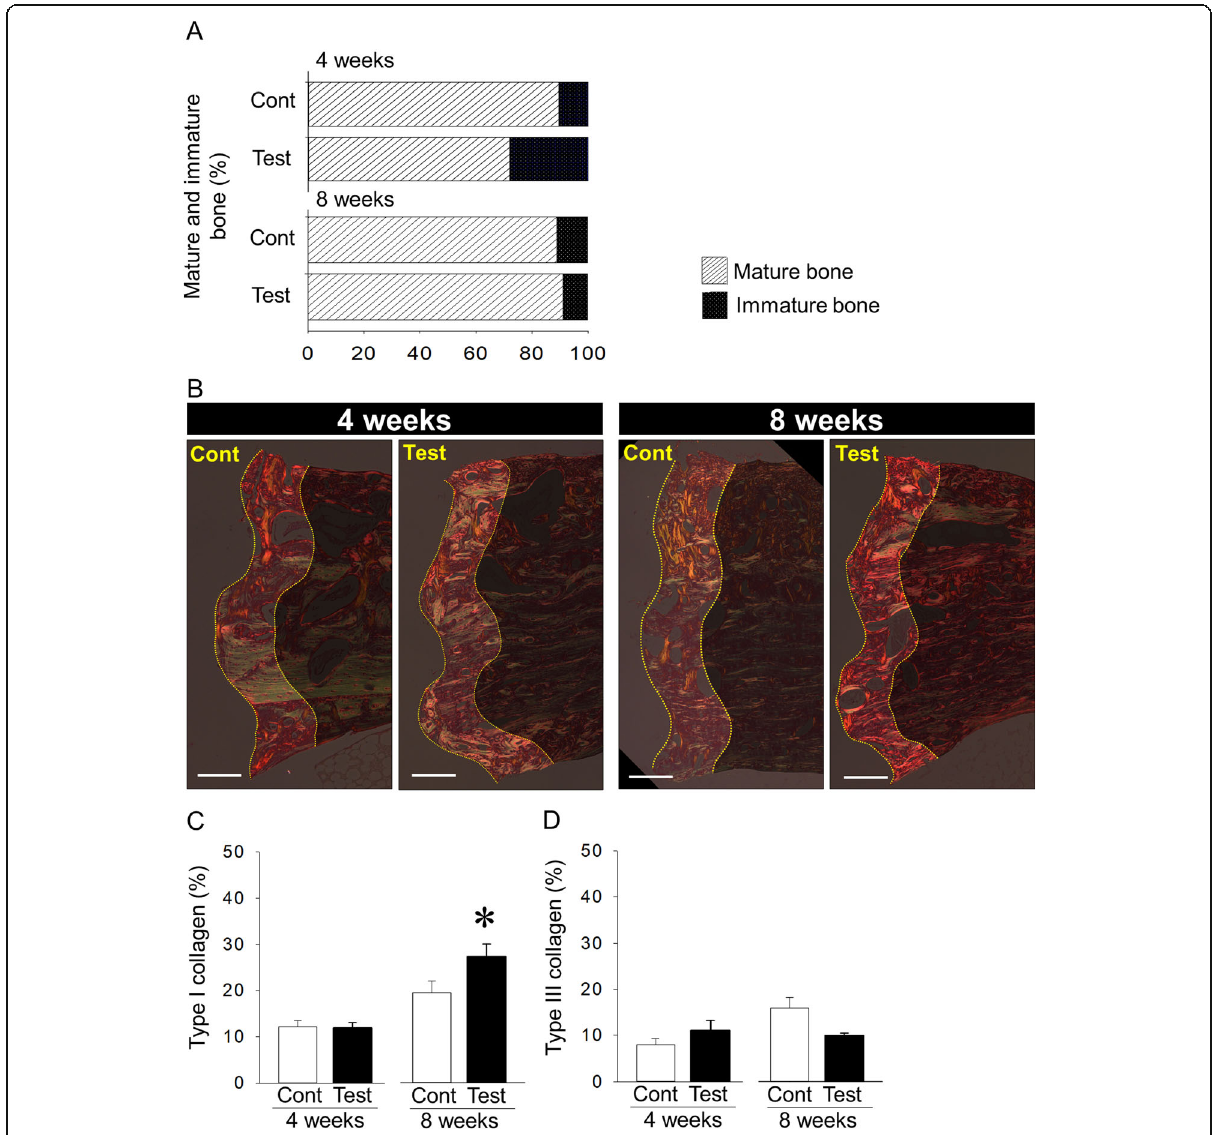
Fig. 4 a Ratios of mature and immature bone to total bone at 4 and 8weeks after implant placement (Cont: control). b Representative picrosirius red-stained images with a polarized light microscope (bar, 250 μ m). c , d Same type I and III collagens between control and test implants 4weeks post-implantation, whereas increased type I and decreased type III collagens at 8weeks after implant placement when compared with control. * p < 0.05, n = 7/each